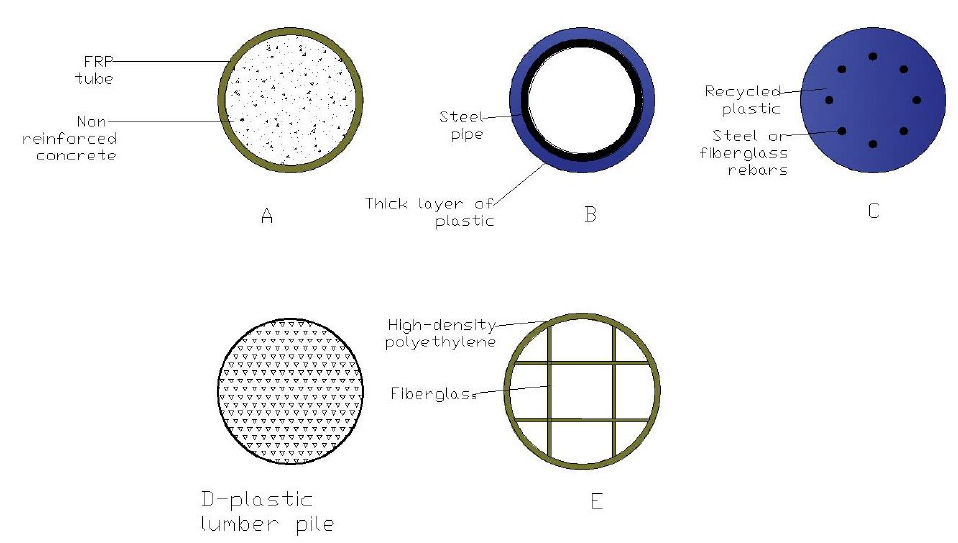
Figure 8. Composite pile types: ( A ) fiber-reinforced polymer (FRP) piles, ( B ) steel core plastic (SCP) piles, ( C ) structurally-reinforced plastic (SRP) piles, ( D ) plastic lumber (PL) piles, and ( E ) fiberglass ultruded (FP) piles.